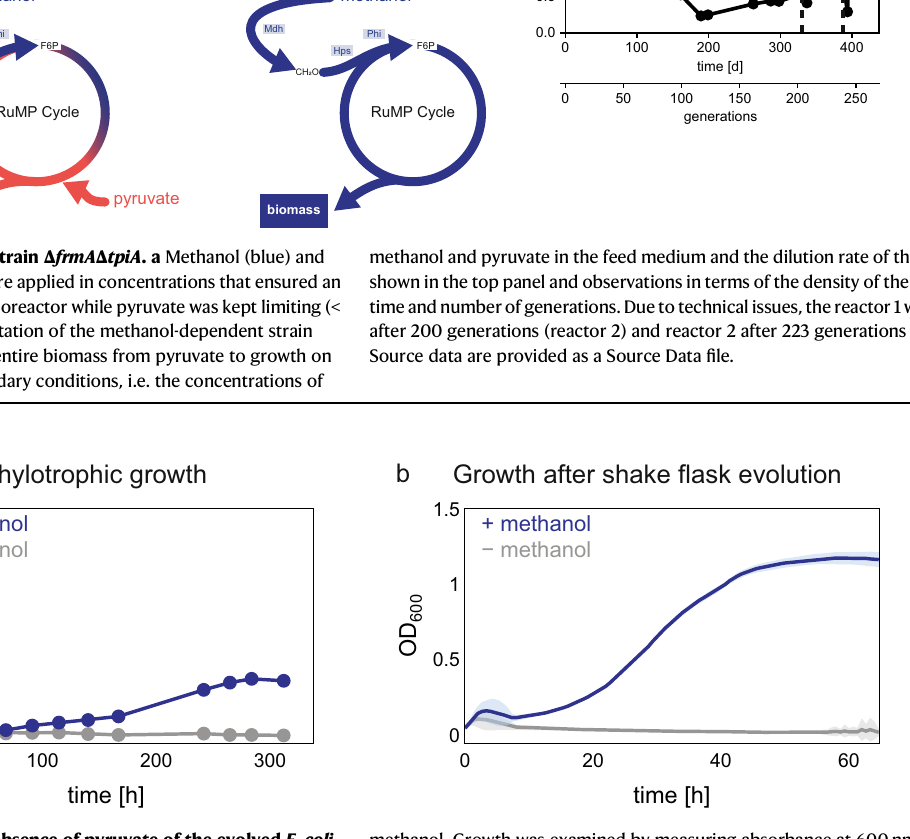
that alter individual protein kinetic parameters, by mutations in reg- ulators and promoters or any combination thereof. To observe poten- tial proteome remodeling, we compared the proteome of the ancestral methanol-dependent E. coli strain grown on methanol and pyruvate to the proteome of the methylotrophic MEcoli_ref_1 grown on methanol alone. Indeed, about 20% of the detected proteins were differentially expressed between the two strains (1494 detected proteins, differential expression cutoff |log 2 (fold-change)| ≥ 1.5) (Supplementary Fig. 4, Supplementary Data 1). Overall, enzymes of the RuMP cycle, the